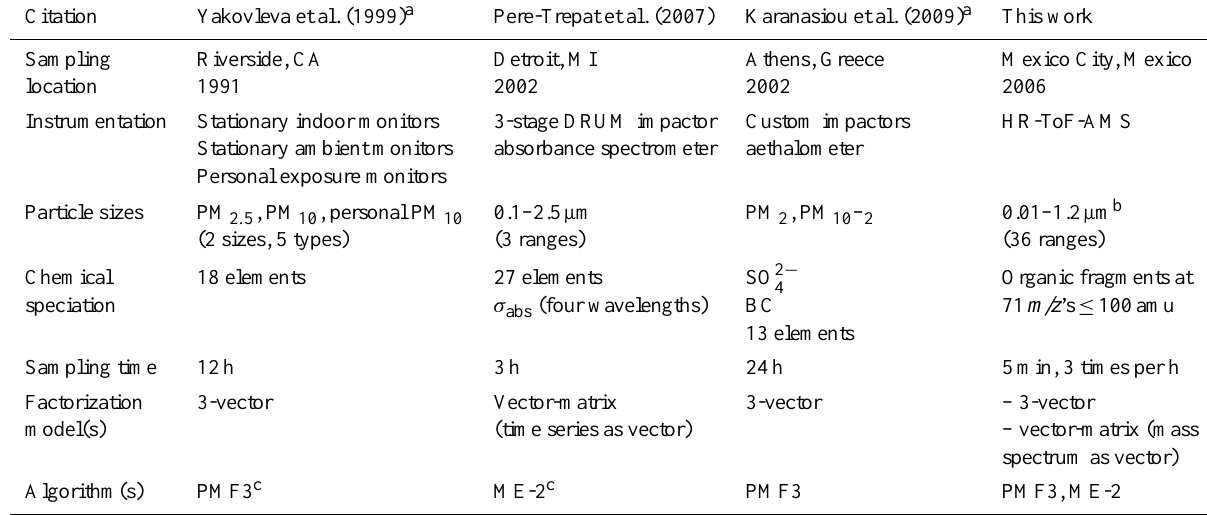
Table 1. Details of research that applied 3-D factorization techniques to datasets of size-resolved aerosol chemical